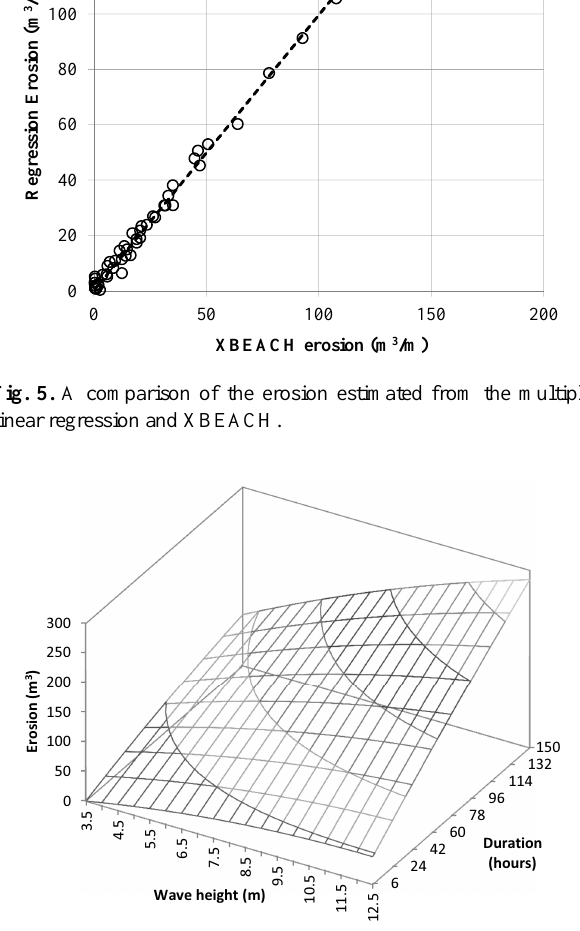
Fig. 6. Surface plot of erosion as a function of wave height H and storm durations D , for the given wave period T = 16s and water level W = 1 . 0m above mean sea level. Contours of erosion levels 50, 100, 150, 200, 250m 3 m − 1 are shown on the surface. Corre- sponding erosion return periods can be inferred from Fig. 4.